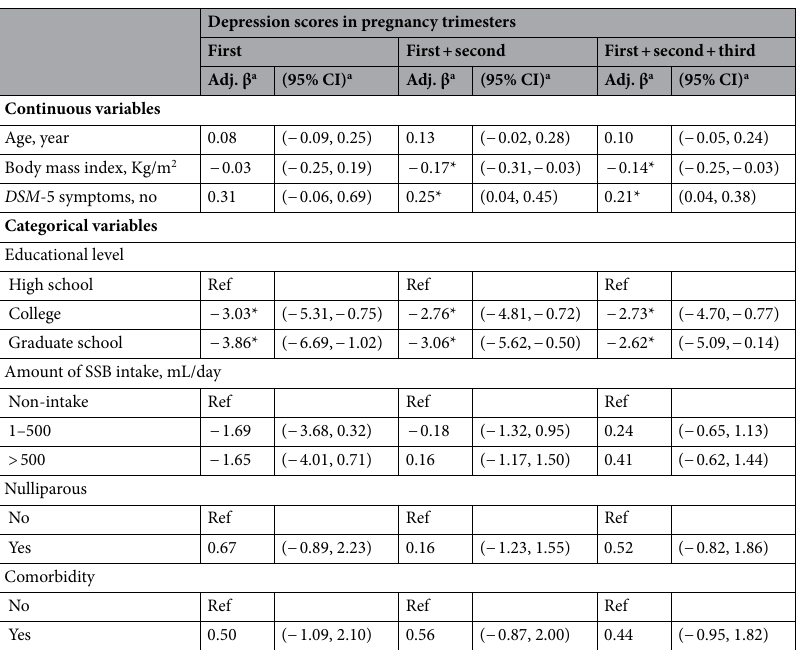
Table 5. The adjusted mean differences of depression scores during pregnancy periods associated with DSM-5 symptoms of sugar-sweetened beverage (SSB) intake and potential risk factors. a Adjusted regression coefficients (Adj. β) were adjusted for all covariates listed in the table. The 95% confidence interval (CI) were calculated for the Adj. β *Denotes p value <